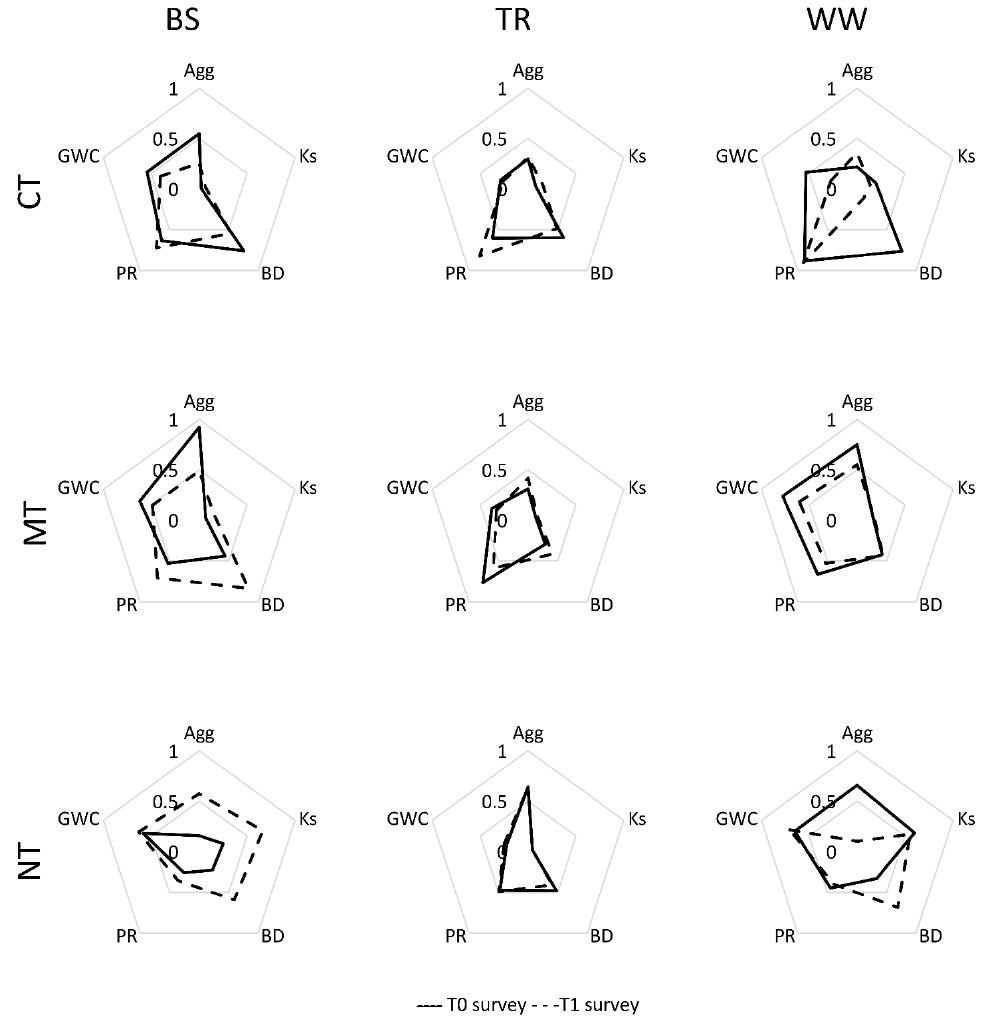
Figure 2. Physical parameter scores with average values in treatment combinations in T0 and T1 surveys (Agg — aggregate stability; BD — bulk density; GWC — gravimetric water content; PR — pen- etration resistance; Ks — saturated hydraulic conductivity; BS — bare soil; TR — tillage radish; WW — winter wheat; CT — conventional tillage; MT — minimum tillage; NT — no tillage). Figures 1 and 2 show sizeable differences between the treatment combinations and two years. The correlation matrix between each parameter pair is shown in Table 4. As expected, the highest correlation resulted between the C org and N tot (r = 0.924). To iden- tify which of these highly-correlated parameters could best explain treatment variation — and warrant inclusion in the RSI — we performed a principal component analysis (PCA). Table 5 presents the PCA results. Each parameter was weighted according to the treatment variation it explained based on the PC selected.